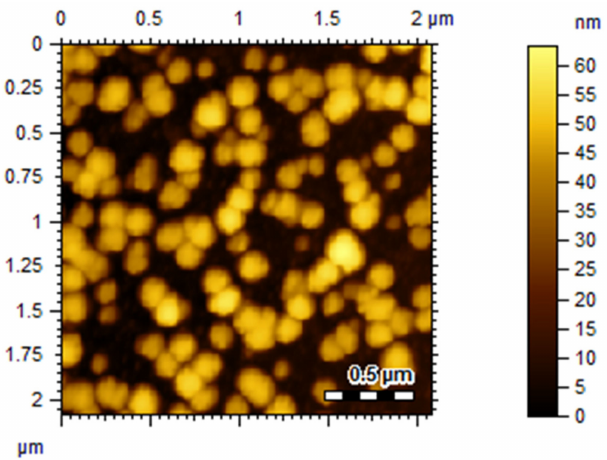
Figure 2. Surface morphology of